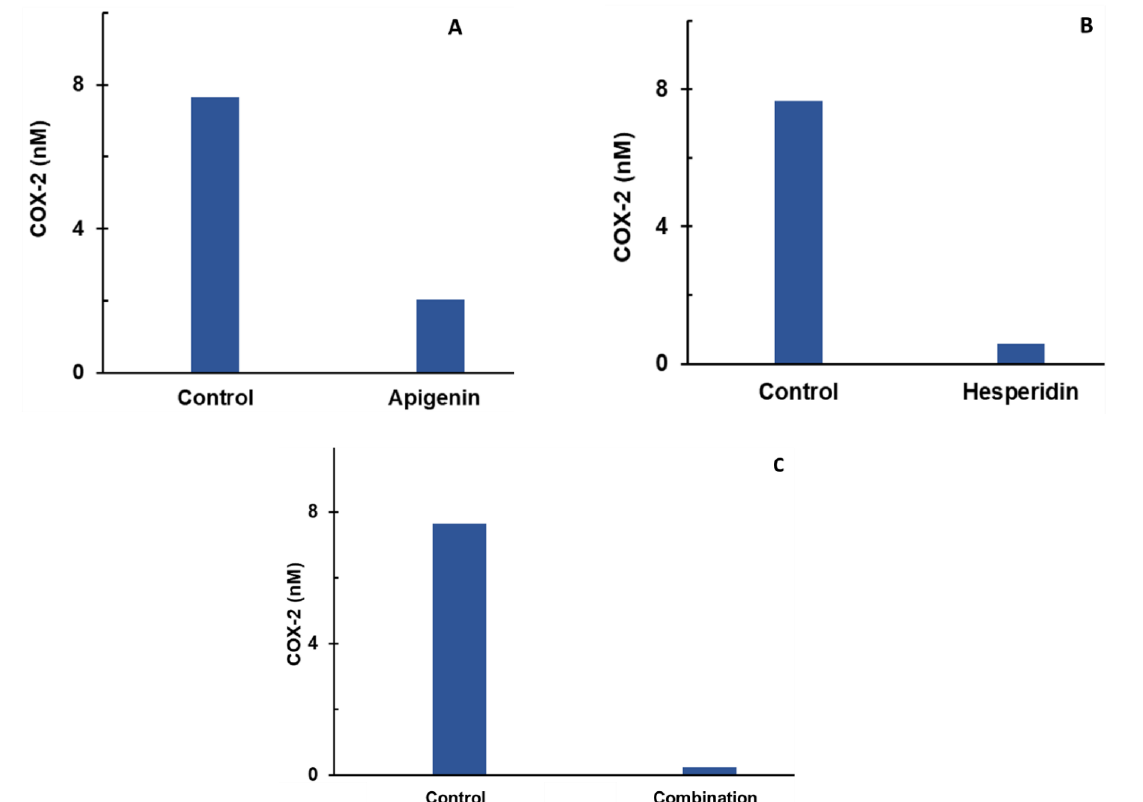
Table 1. COX-2 estimations for additive effects of apigenin and hesperidin.